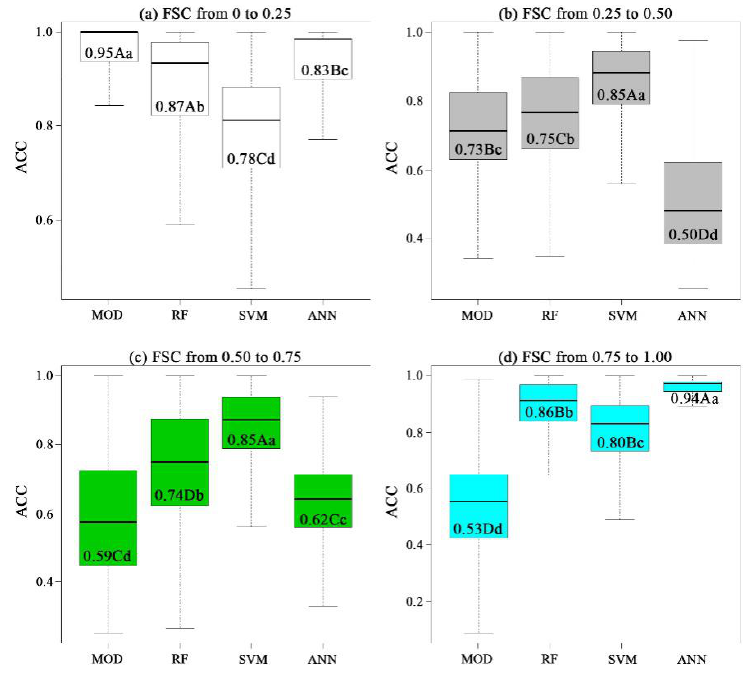
Figure 7. Boxplots of the accuracy distributions of MOD10A1 (MOD), random forest (RF), support vector machine (SVM) and back-propagation artificial neural network (ANN) under various fractional snow cover gradients over the Tibetan Plateau. Labels are composed of the average accuracy and the results of the significance tests (in the case of p < 0.05). The uppercase letters represent the accuracy of the specific model from high to low (A to F) among different FSC gradients, while the lowercase letters represent the accuracy from high to low ( a - d ) among the four FSC models for each gradient.